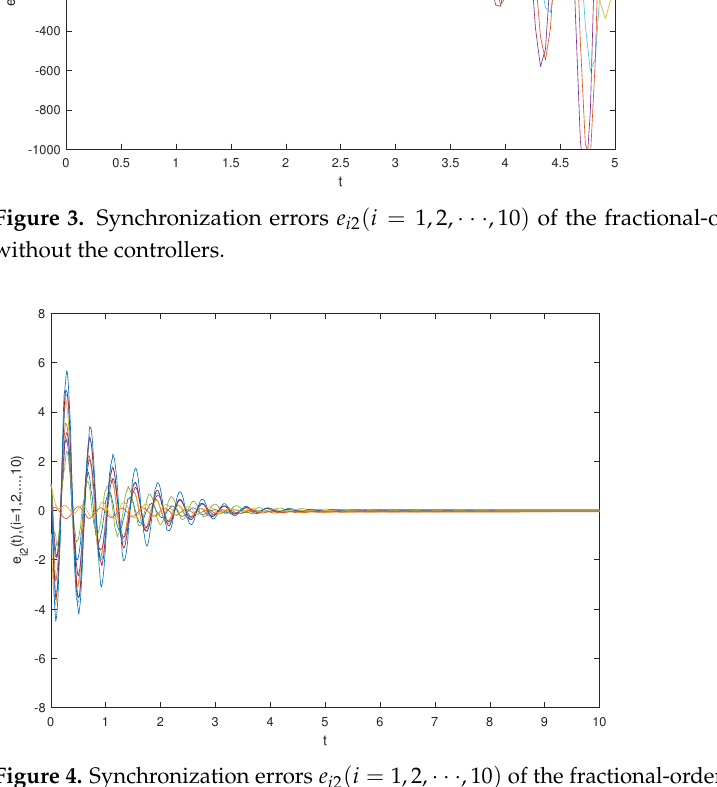
Figure 4. Synchronization errors e i 2 ( i = 1,2, · · · ,10 ) of the fractional-order system (32) and (33) with the